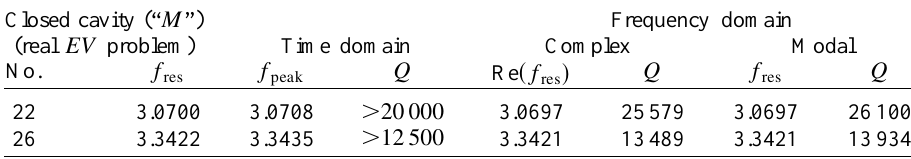
TABLE IV. Some resonance frequencies (in GHz) and Q factors in the open three-cell cavity. Closed cavity (“ M